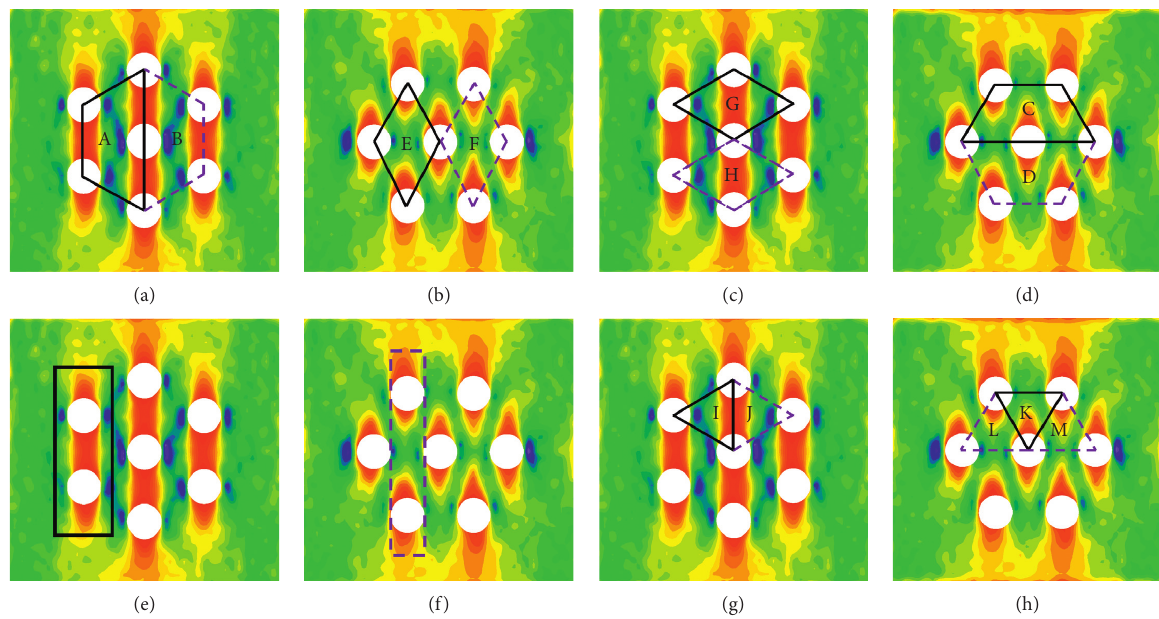
Figure 13: Decomposition diagram of hole combination (in the figure, the blue area is the main concentration area of compressive stress, and the red area is the main concentration area of tensile